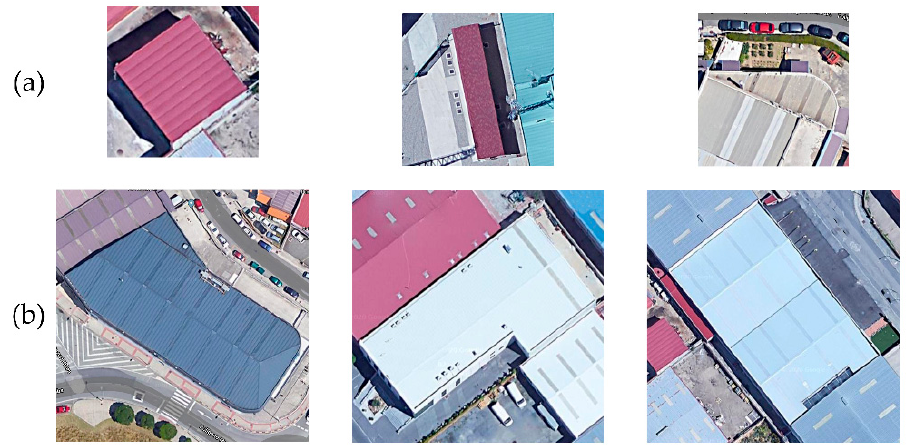
Figure 7. Example of industrial building roofs used for the evaluation of the effect of the point cloud density in the surface computation error: ( a ) <200 m 2 , ( b ) >200 m 2 .